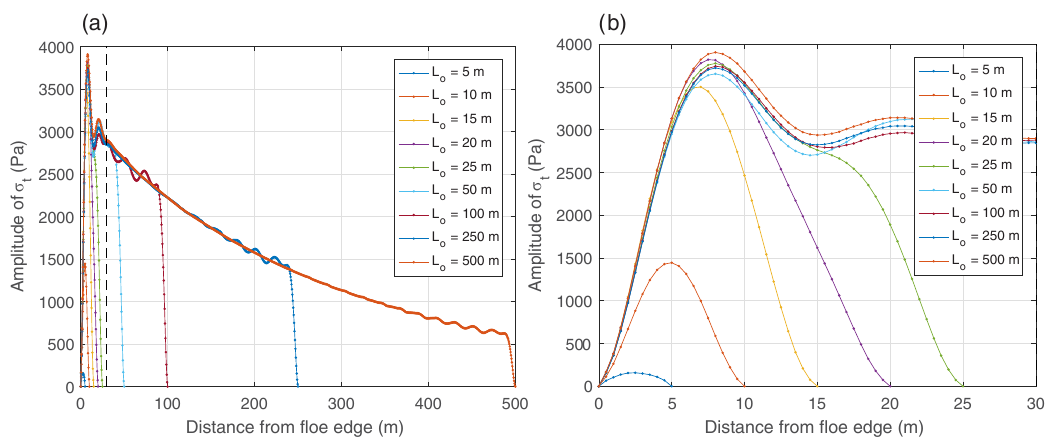
Figure 7. Amplitude of the tensile stress σ t in function of the distance from the up-wave ice edge for different floe length L o ; open-water wavelength is L w , 0 = 42m, and ice thickness is h i = 0 . 5m. The plot in panel (b) is a close-up of the region to the left of the dashed line in panel (a)